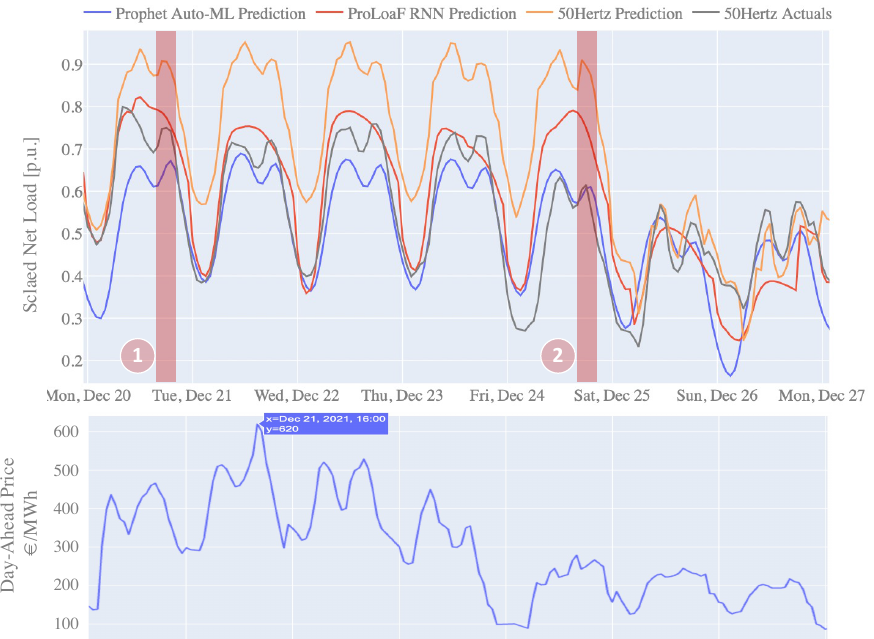
Figure 10. Comparison of forecast profiles with actual load in winter week 2021 with